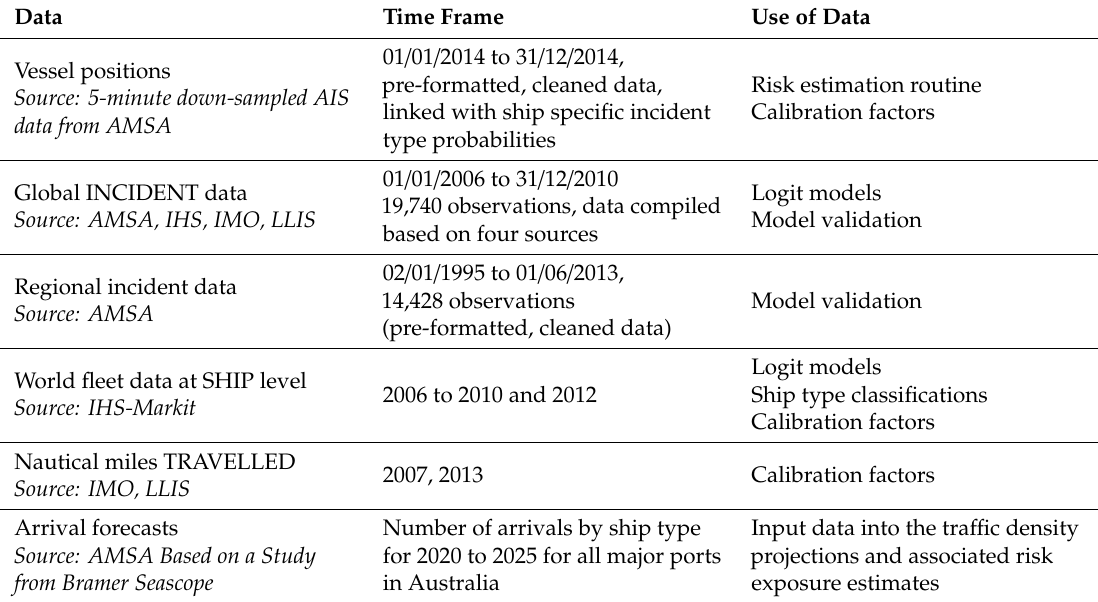
Table 1. Summary of data, data sources, and time frames